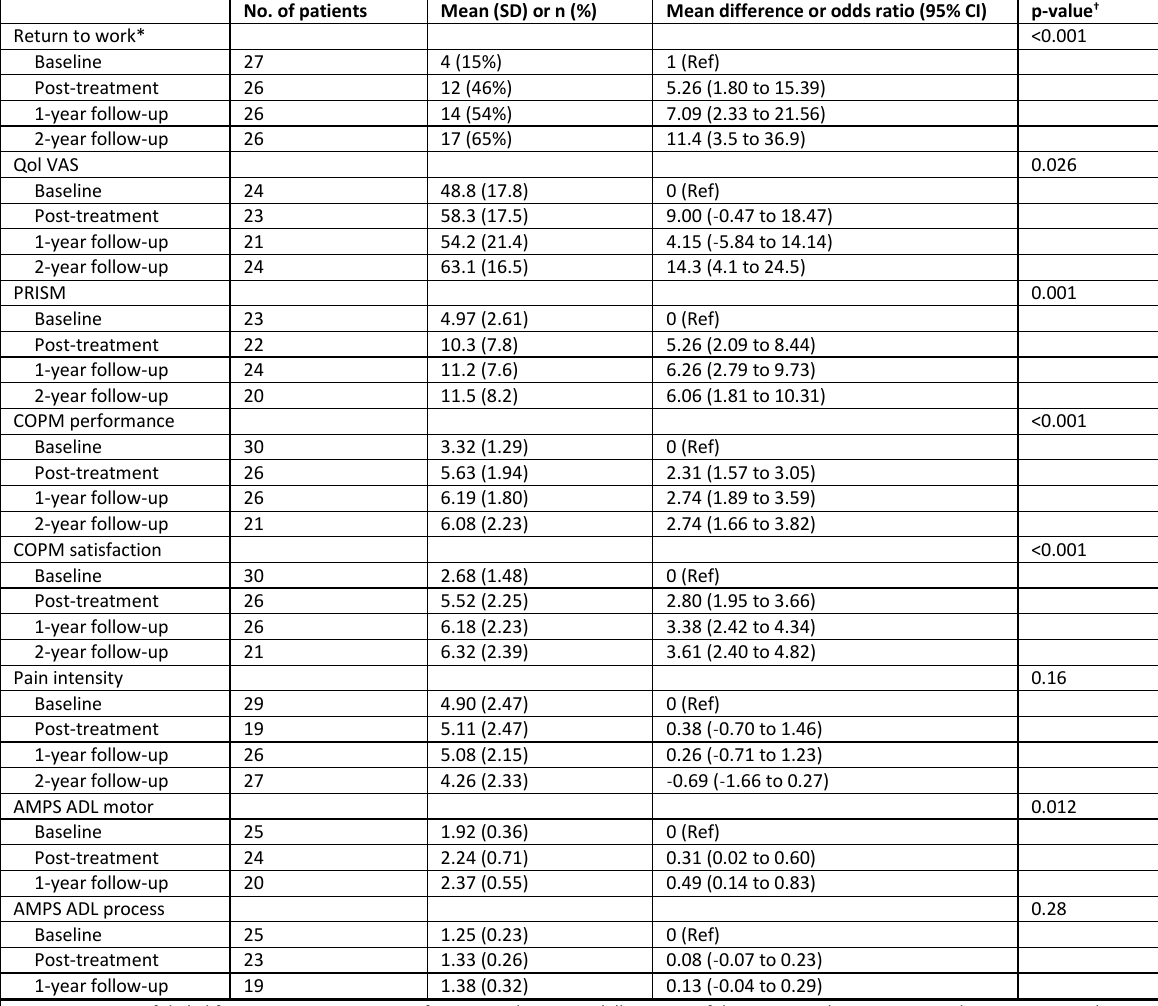
Table 3: Mean differences or odds ratio compared with baseline at each time point with 95% confidence interval and p-value for the overall effect on time. No. of